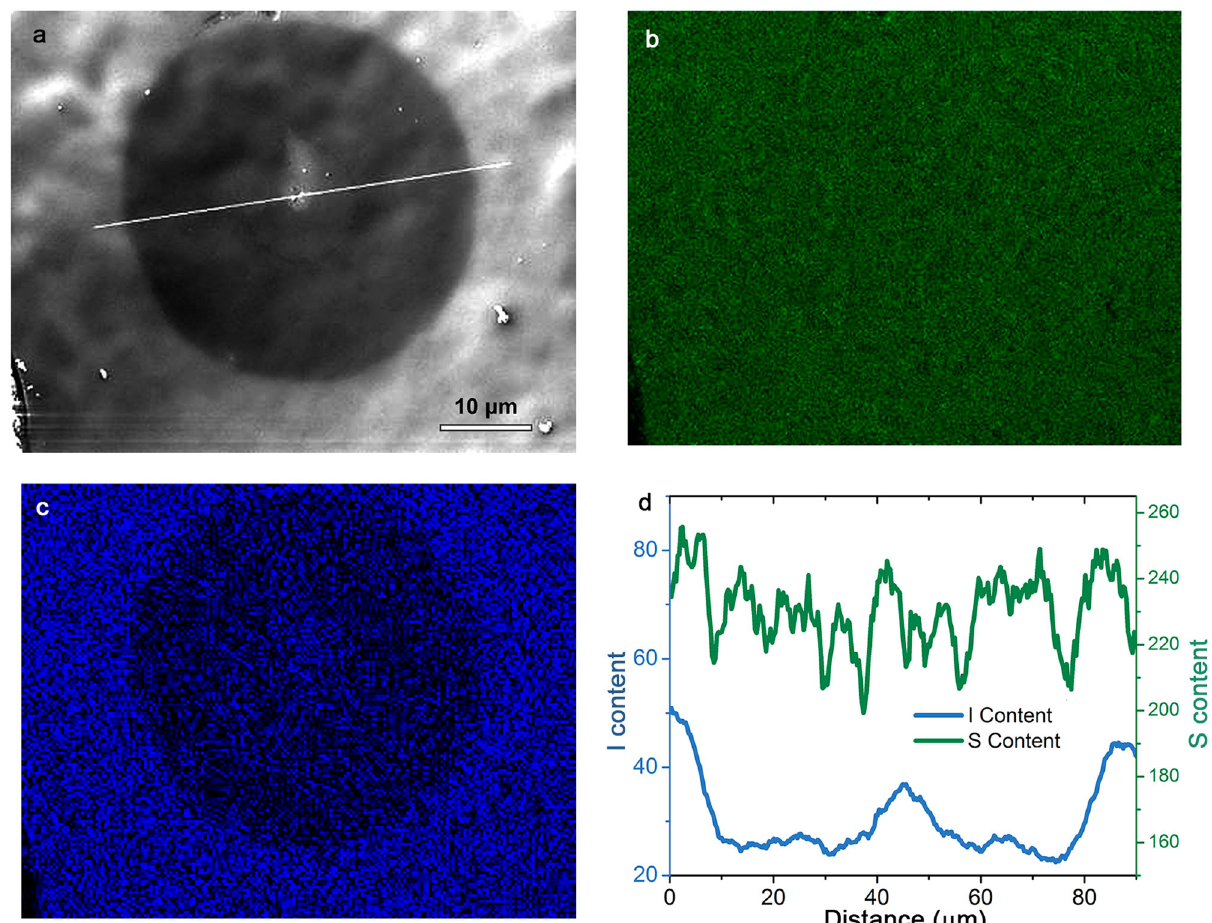
Fig. 4 SEM and EDX analysis of the (BEDO-TTF) 2.4 I 3 after positive voltage bias application. a SEM image showing the discolored region around the Pt-tip and the EDX linear-scan range (white line). EDX elemental maps showing the distribution of b sulfur and c iodine contents of